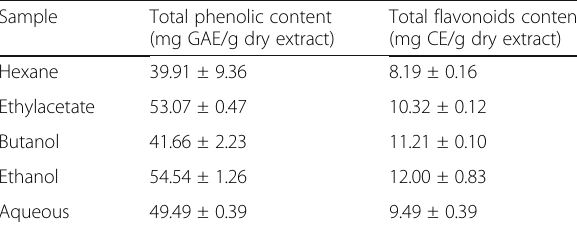
Table 2 Total phenolic and flavonoids content of Cynara scolymus leaves extracts Sample